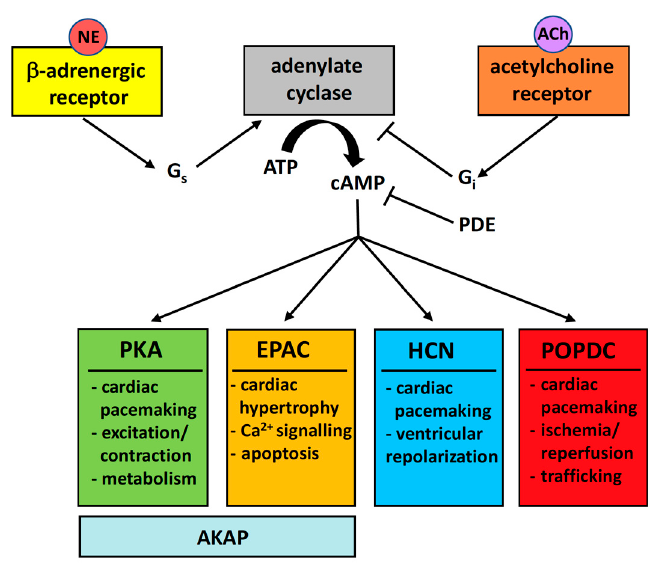
Figure 1. Four cAMP effector proteins are expressed in the heart. Norepinephrine (NE) secreted by sympathetic neurons binds to the β -adrenergic receptor leading to G s activation and synthesis of cAMP by adenylate cyclase (AC). Acetylcholine (ACh) is secreted by parasympathetic neurons and binds to muscarinergic ACh receptors leading to an activation of G i causing AC inhibition. The balance of sympathetic and parasympathetic input therefore determines the level of cAMP production. cAMP production in cells is compartmentalized and this is mainly achieved by phoshodiesterases (PDE), which limits cAMP diffusion through degradation. Four effector proteins sense cAMP levels. The best-characterized effector protein is protein kinase A (PKA), which plays a role in cardiac pacemaking, excitation/contraction coupling and cardiac metabolism. The exchange factor directly activated by cAMP (EPAC) has been linked to cardiac hypertrophy, Ca 2+ -signaling and apoptosis. Often, PKA and EPAC are bound by the same anchor protein (AKAP) along with protein substrates and other enzymes. The hyperpolarization-activated cyclic nucleotide-gated (HCN) channels are important for cardiac pacemaking and ventricular repolarization. Finally, the Popeye domain containing (POPDC) proteins are the most recently identified class of effector proteins and important for cardiac pacemaking, the survival of cardiac myocytes after ischemia/reperfusion and membrane trafficking.